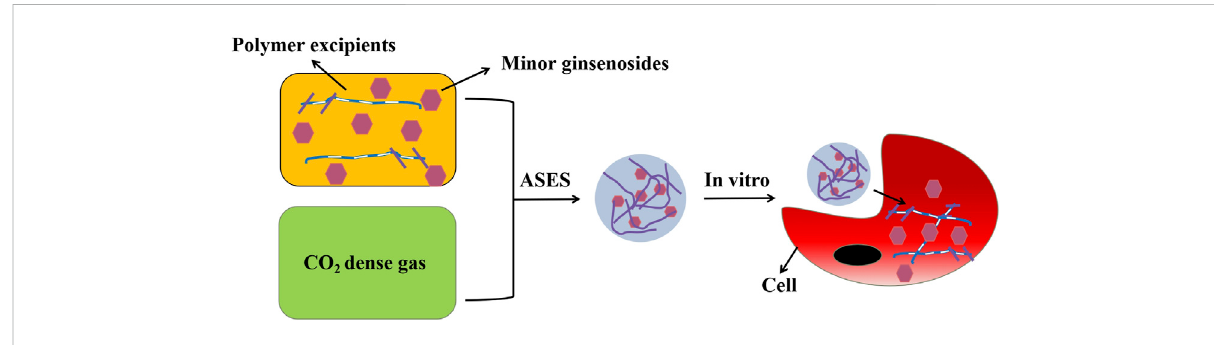
FIGURE 1 Preparation process and cell uptake